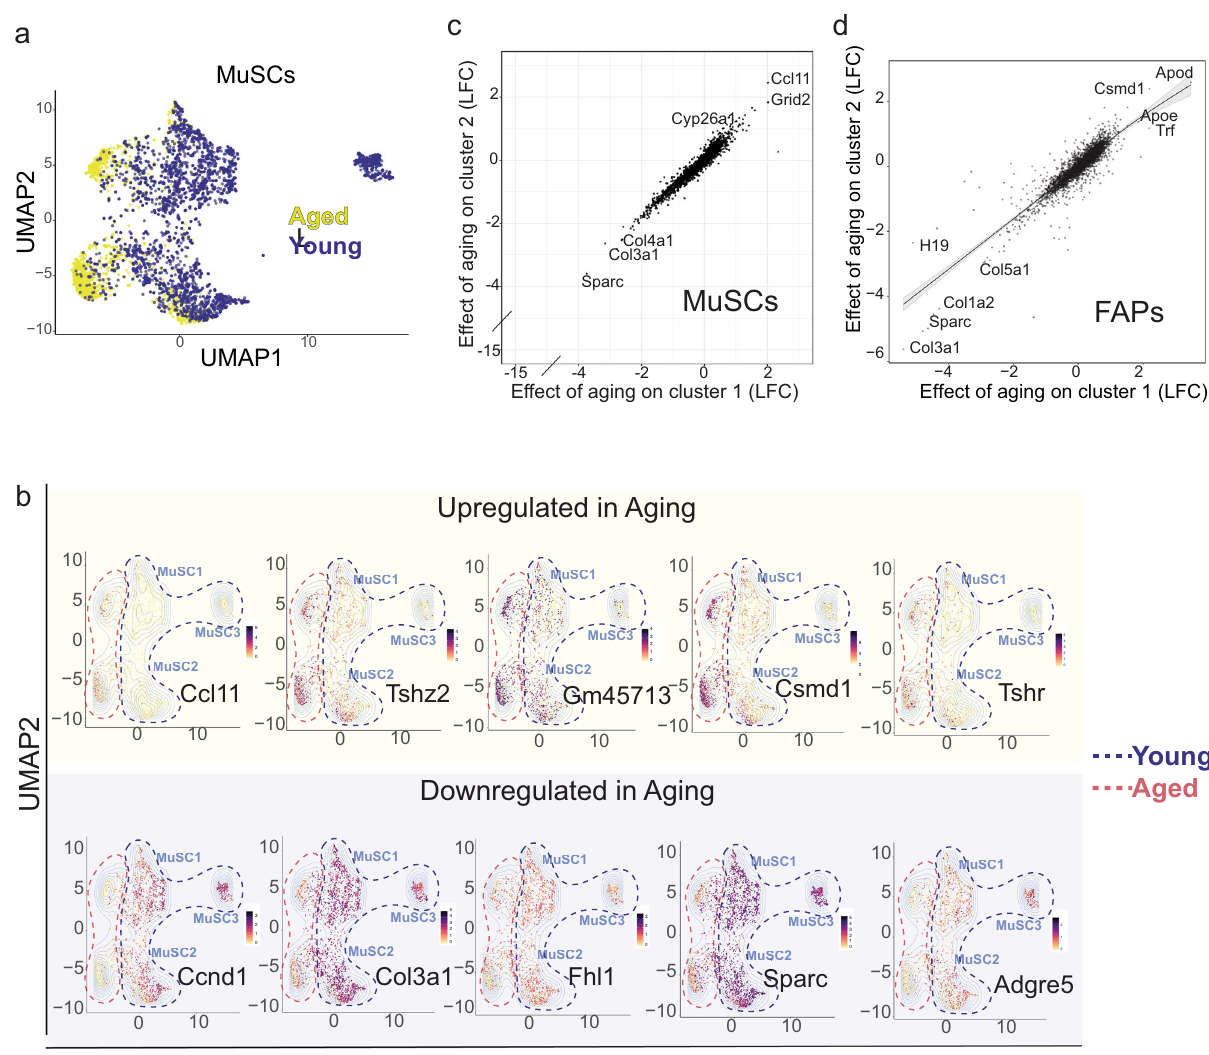
Fig. 3 | Aging impinges upon commongenes across distinct clusters of MuSCs. a UMAPembeddingofMuSCs,coloredbasedonage. b Geneexpressionplotsinthe UMAP embedding for select representative genes that are up or downregulated in aging, ranging from highest (black) to lowest (yellow) expression. c Scatterplot